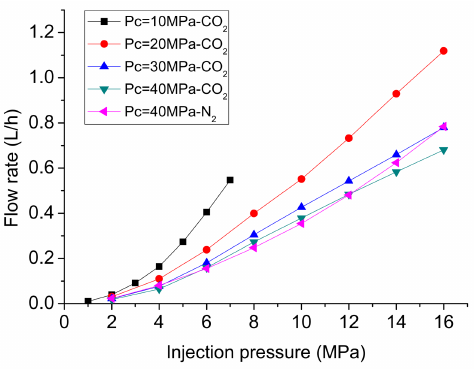
Figure 4. Variation of downstream flow rates with injection pressure under steady-state